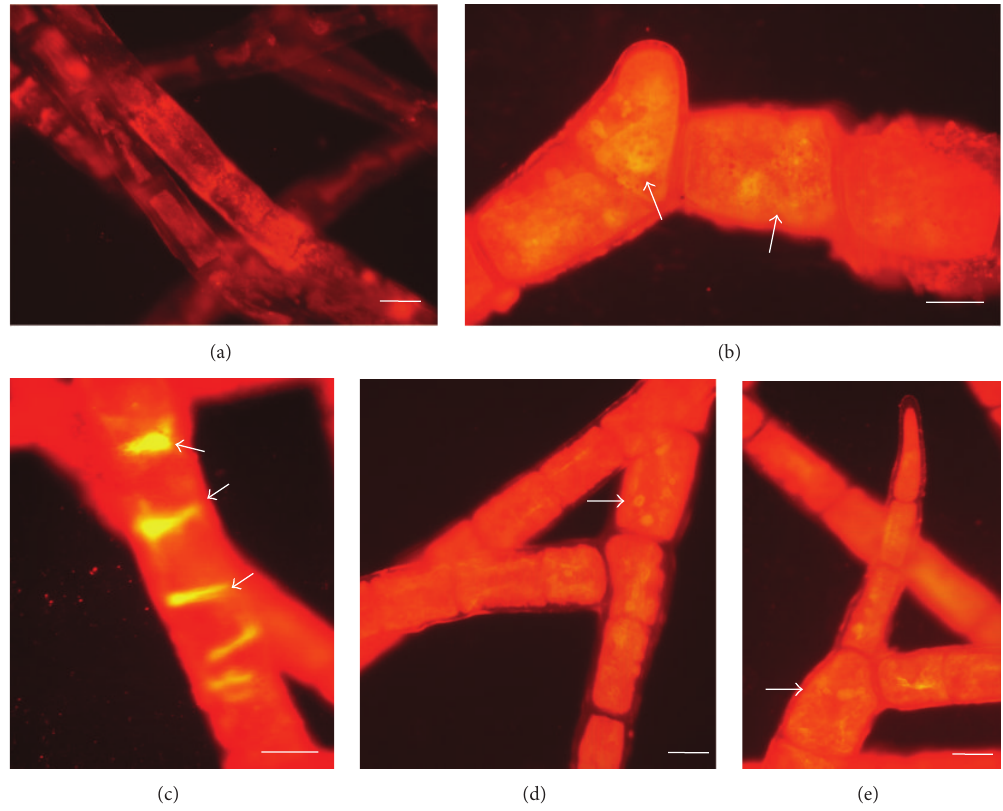
Figure 5: Showing fluorescent images of R . africanum . (a) Untreated cells with red chlorophyll autofluorescence. (b) Accumulation of neutral lipid in rhizoidal branch after DDN in the culture. (c) Bright yellow fluorescence due to the accumulation of more neutral lipid in AN treated culture. (d) Rhizoidal branch with nonpolar lipid droplets (yellow droplets) in DDP added culture. (e) Accumulation of less nonpolar lipid in the rhizoidal branch under